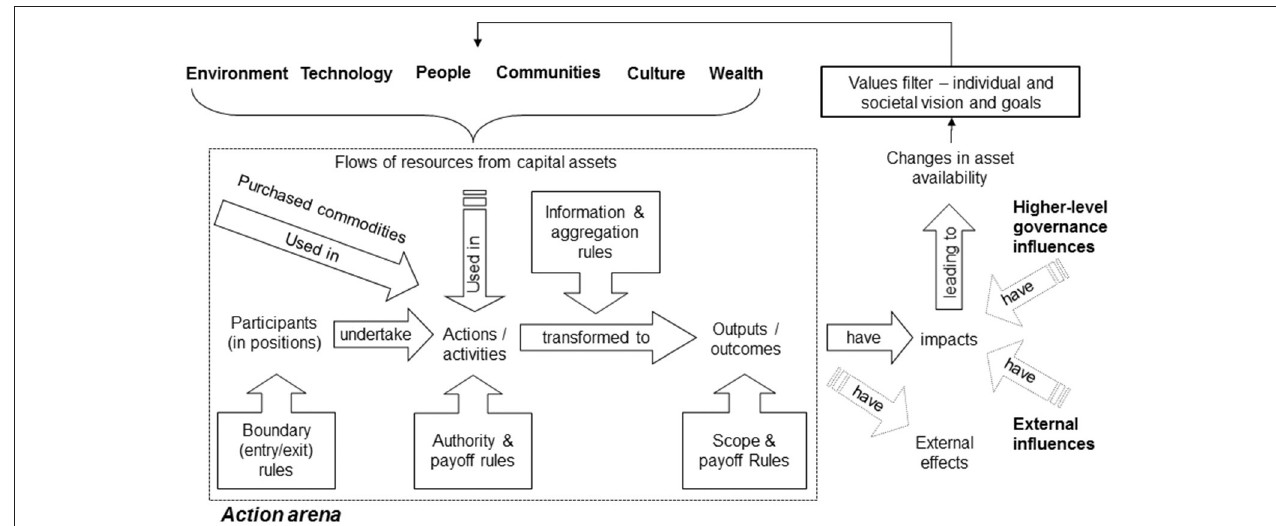
FIGURE 1 | Basic capital asset-based IAD framework (adapted from Sutton and Rudd,